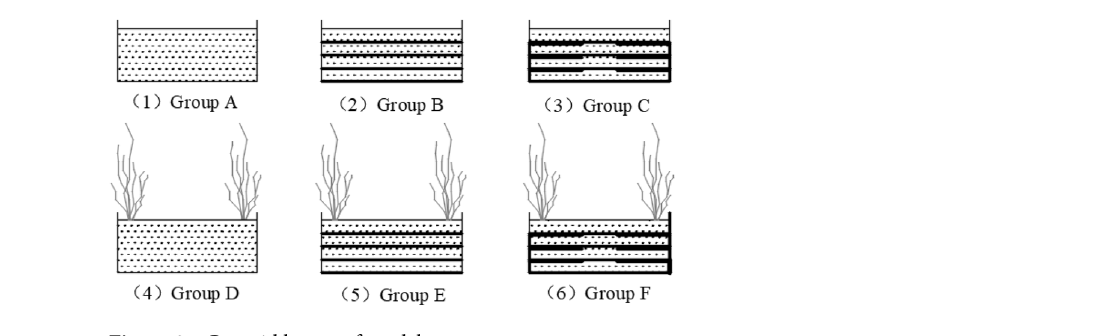
Figure 3. Geogrid layout of models.